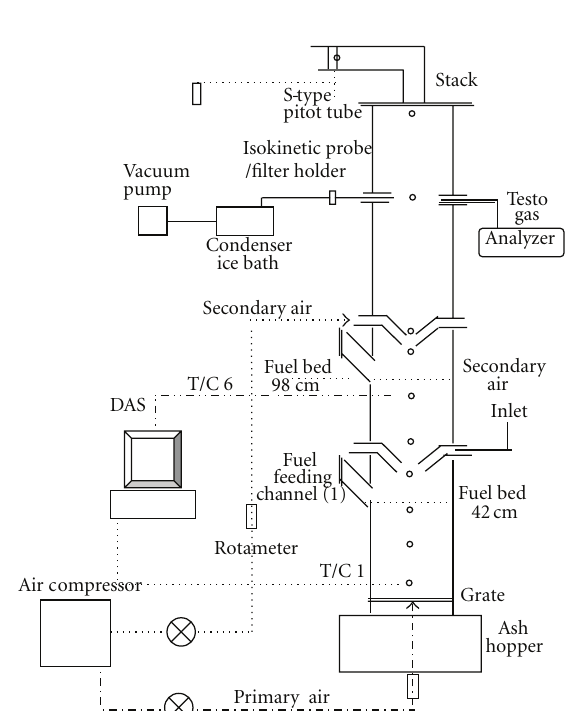
Figure 2: Fixed-bed combustor and particulate sampling